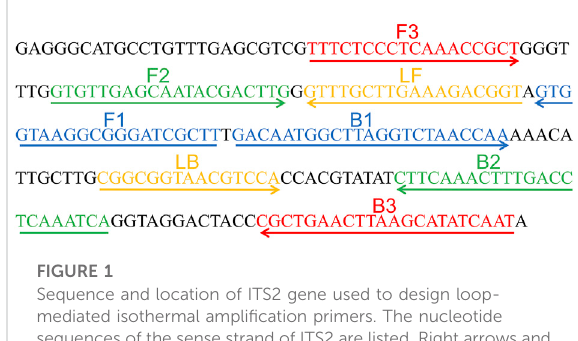
FIGURE 1 Sequence and location of ITS2 gene used to design loop- mediated isothermal ampli fi cation primers. The nucleotide sequences of the sense strand of ITS2 are listed. Right arrows and left arrows indicate sense and complementary sequences that are used.